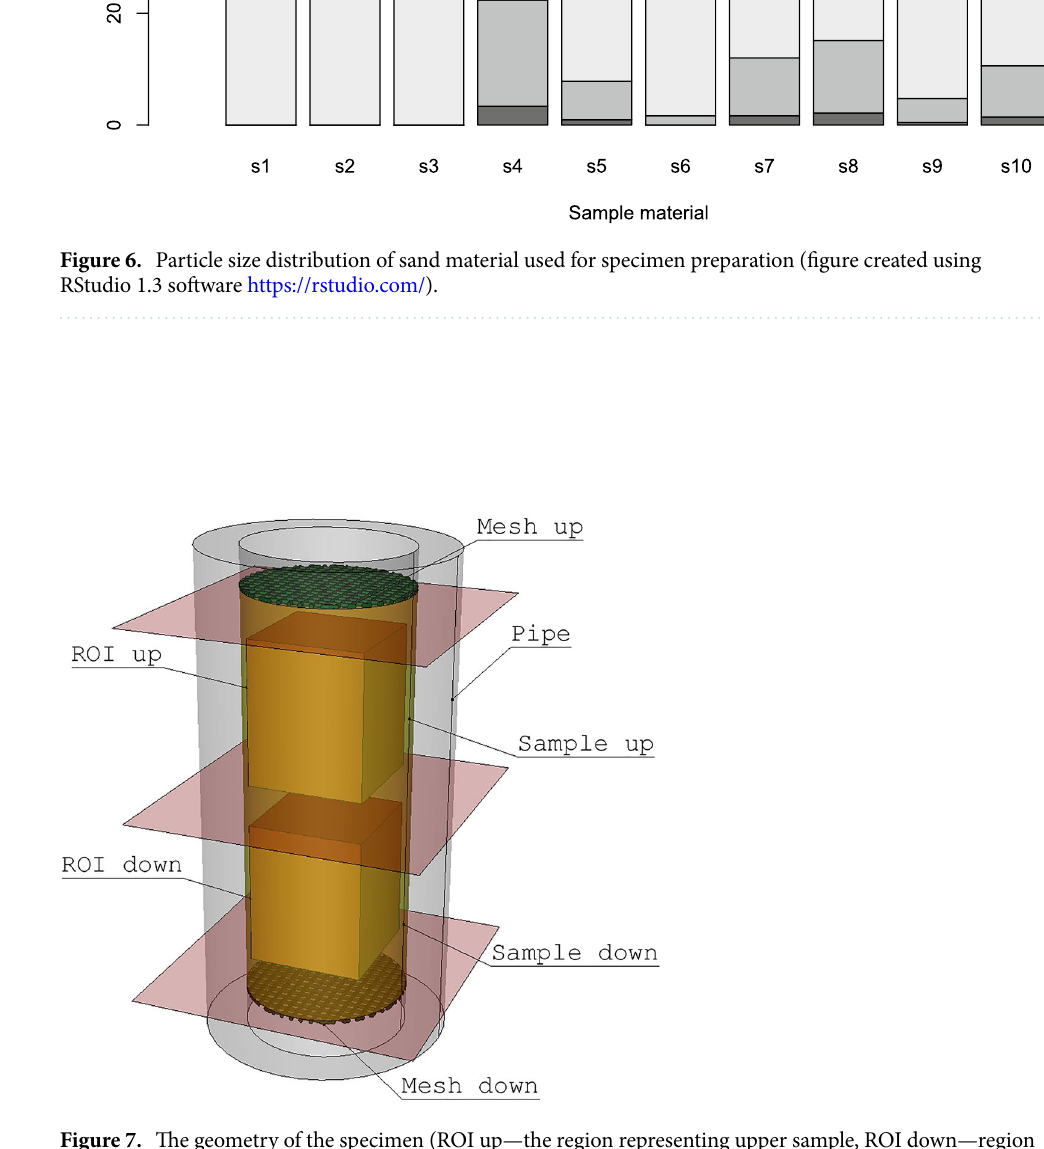
Figure 7. The geometry of the specimen (ROI up—the region representing upper sample, ROI down—region representing lower sample; Figure created using Salome 9.6 software https ://www.salom e-platf